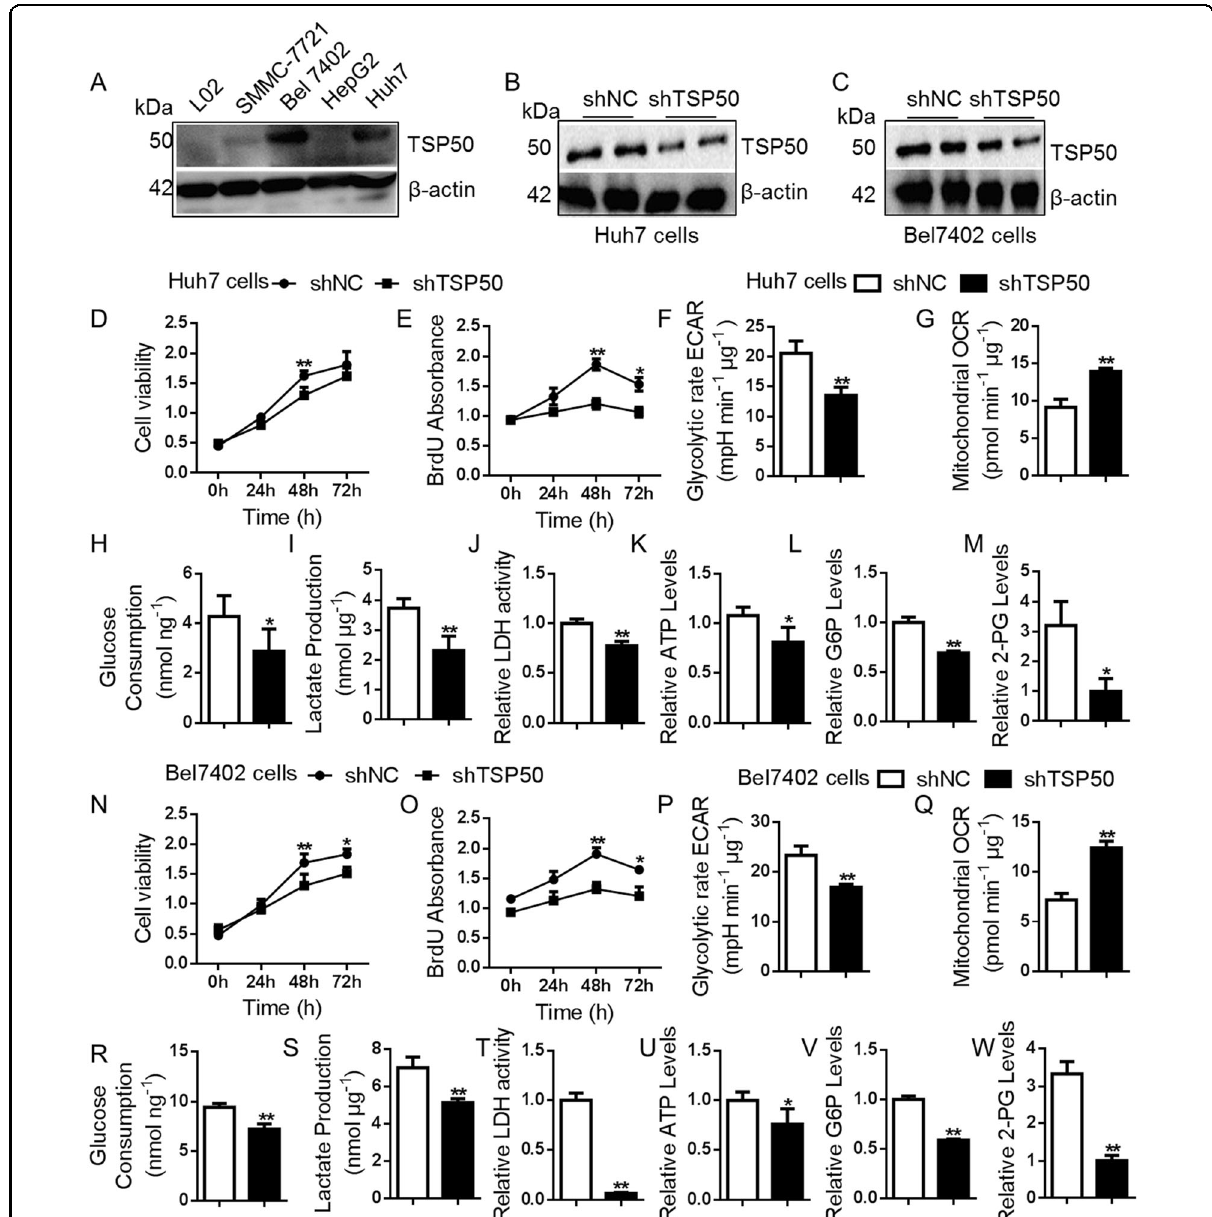
Fig. 2 shTSP50 affects cell proliferation and aerobic glycolysis. A Multiple cancer cells were cultured, harvested and subjected to Western blot analysis for TSP50 detection. B – C shTSP50 was transfected into Huh7 and Bel7402 cells for the gene knockdown and the knockdown ef fi ciency was evaluated. β -actin served as loading control. D , E The Huh7 cell viability and BrdU absorbance were detected in cells after shTSP50 transfection by MTT and BrdU assay. F – M After shTSP50 transfected in Huh7 cells, the ECAR, OCR, glucose consumption, lactate production, LDH activity, ATP levels, G6P levels and 2-PG levels were analyzed. N , O The Bel7402 cell viability and BrdU absorbance were detected in cells after shTSP50 transfection by MTT and BrdU assay. P – W After shTSP50 transfected in Bel7402 cells, the ECAR, OCR, glucose consumption, lactate production, LDH activity, ATP levels, G6P levels and 2-PG levels were analyzed. The aerobic glycolysis values were normalized to protein levels. N = 3 biologically independent replicates. Data were presented as means ± s.d. *P < 0.05, **P < 0.01 as compared to NC group by two-sided Student ’ s t -test. ns, no signi fi